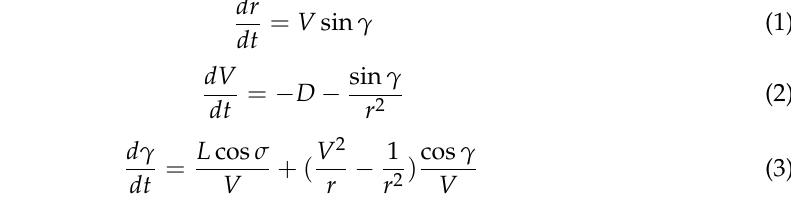
by V f and γ f . Additionally, note that as an infinite small change in bank angle σ leads to a sufficiently small difference in terminal state, the aerocapture attainability set A is a simply connected region in the V f − γ f space. An illustration of an aerocapture attainability set is shown in Figure 2, where the boundary of the attainability set is denoted as O .